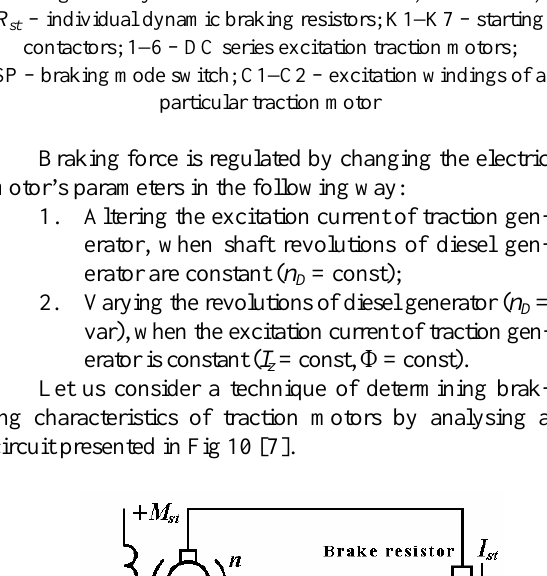
Fig 9. A circuit diagram of electrodynamic diesel locomotive braking: SG – synchronous traction alternator; L – rectifier;